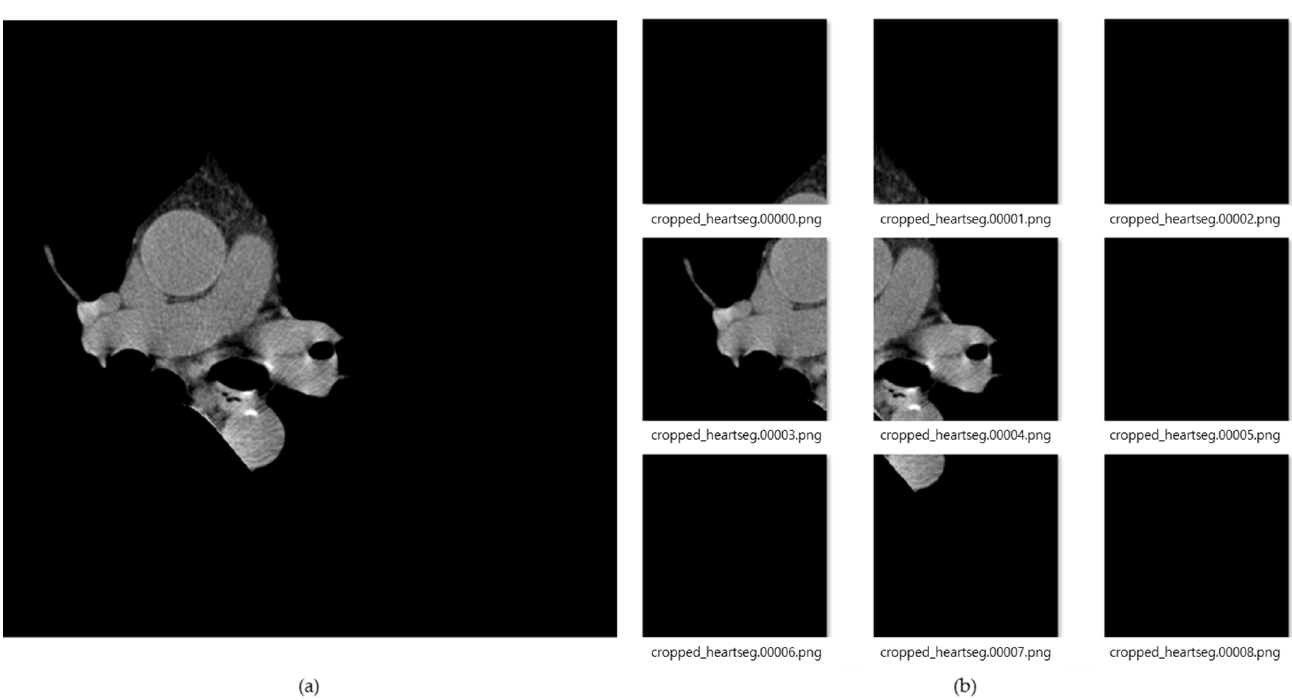
Figure 8. ( a ) Cardiac segmented images, and ( b ) cardiac cropped images created by dividing the segmented cardiac images into 9.